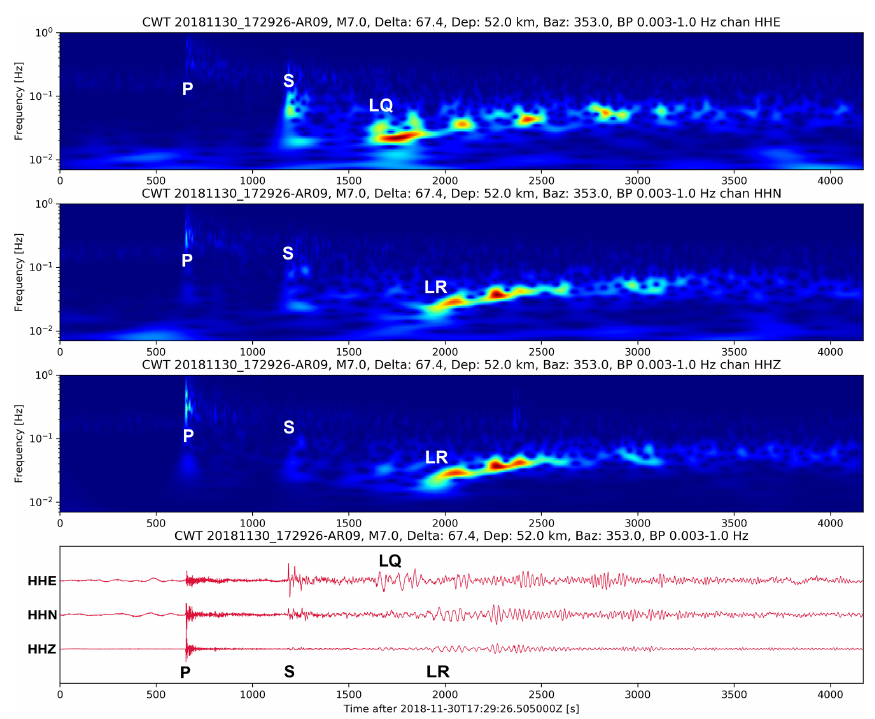
Figure 10. Spectral seismograms obtained with the use of continuous wavelet transform for station AR09, showing a teleseismic event from southern Alaska, 30 November 2018, 17:29:26UTC. From top to bottom: E , N and Z